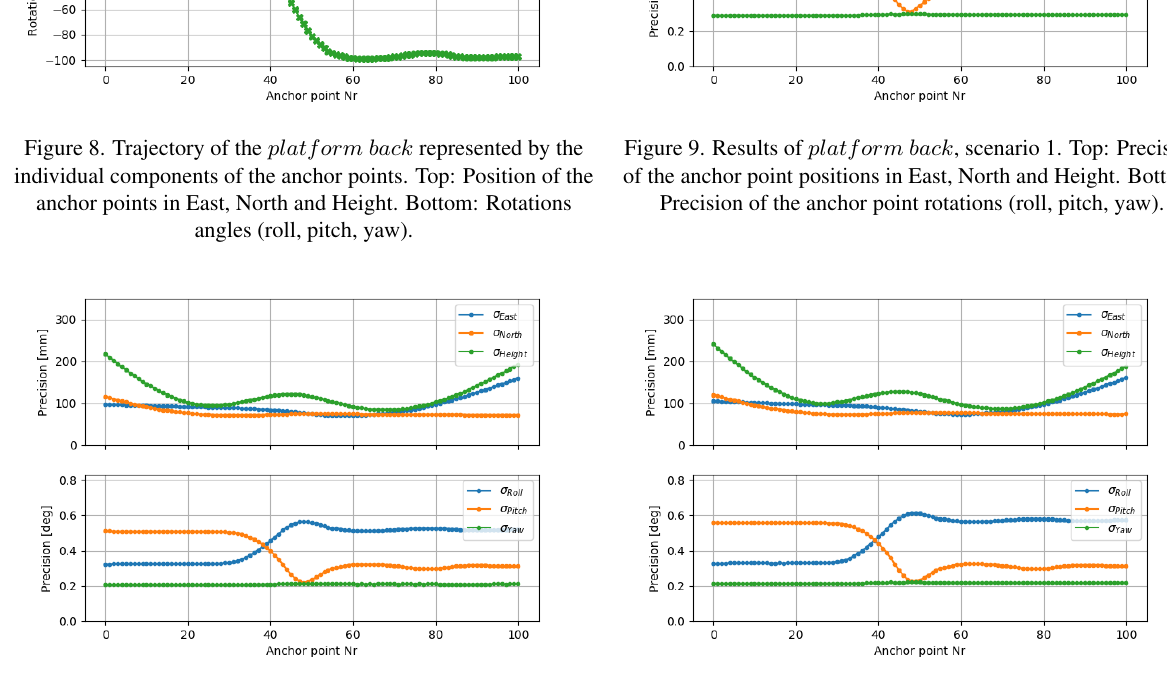
Figure 10. Results of platform back , scenario 2 (details see figure 9).